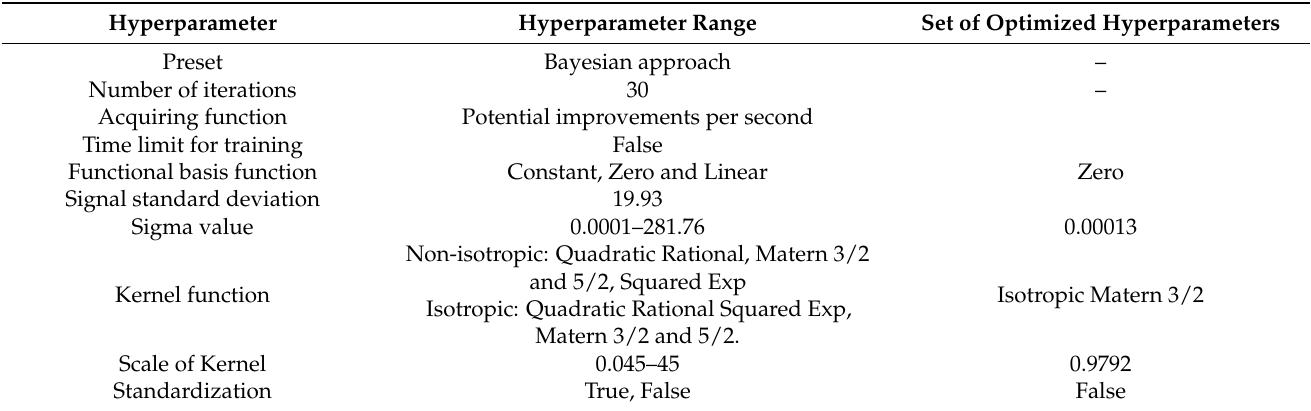
Table 2. Training hyperparameters’ environment and optimized